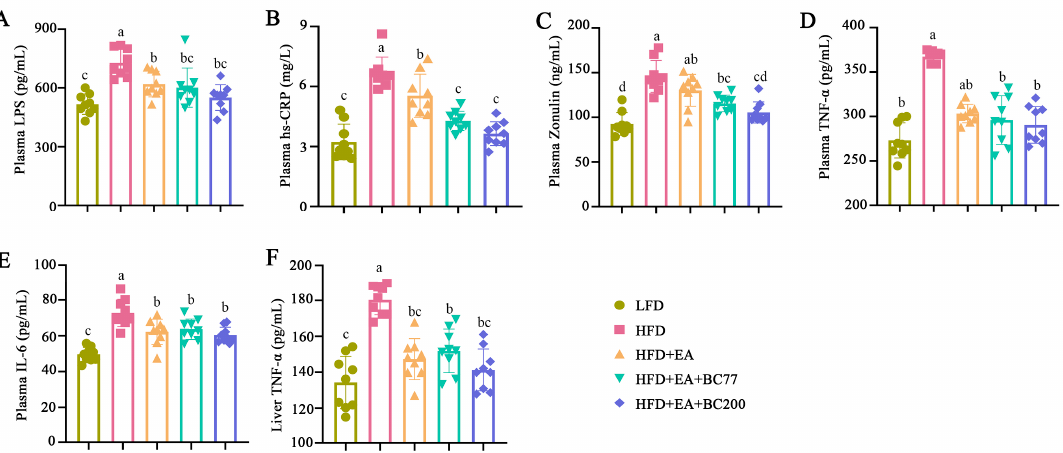
Figure 3. Impact of BC2000 on inflammatory cytokines in obese mice: ( A ) plasma LPS; ( B ) plasma hs-CRP; ( C ) plasma Zonulin; ( D ) plasma TNF- α ; ( E ) plasma IL-6; ( F ) liver TNF- α . Different letters indicate significant differences ( p < 0.05). n = 9/group. Values show mean ± SD. When variances of